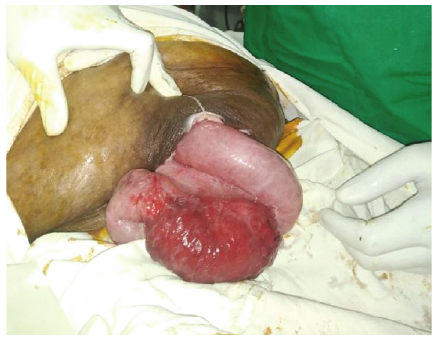
Figure 2: Intraoperative image showing viable small bowel after releasing the